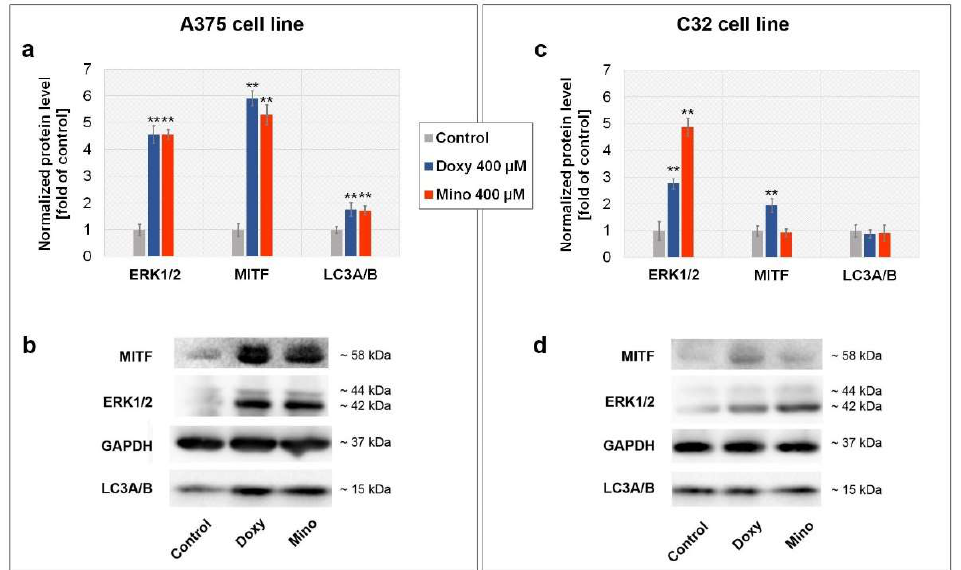
Figure 10. Analysis of ERK1/2, MITF, and LC3A/B level after the treatment of melanoma cells with minocycline and doxycycline. Bar graphs present normalized results for A375 ( a ) and C32 ( c ) cell lines. Corresponding representative blot images ( b , d ) for analyzed proteins are also shown. ** p < 0.005 vs. control.